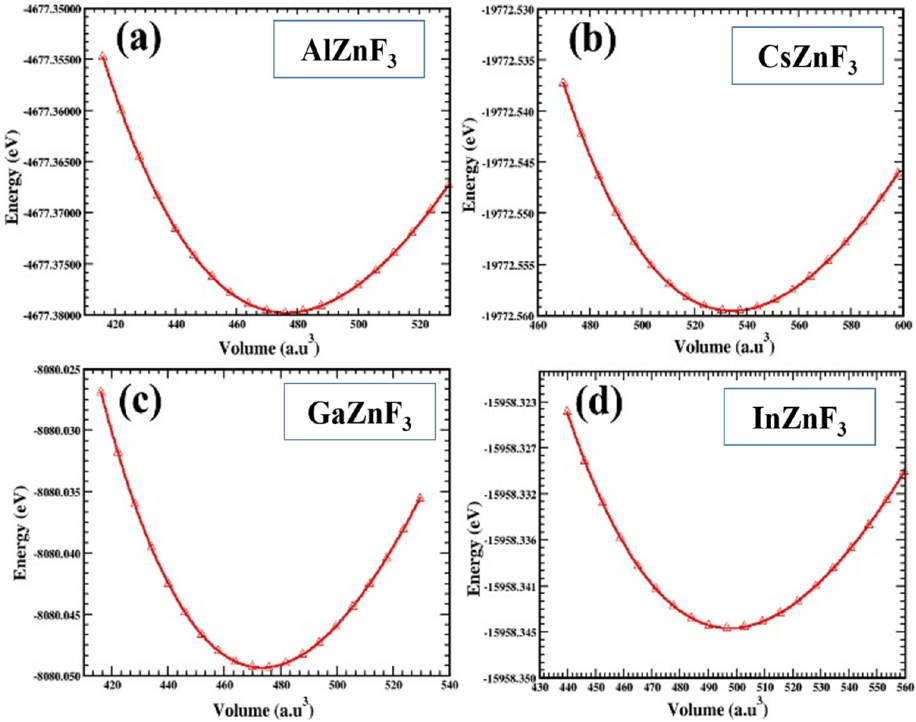
Figure 2. Variation in energy against volume for XZnF 3 (X = Al, Cs, Ga, In).